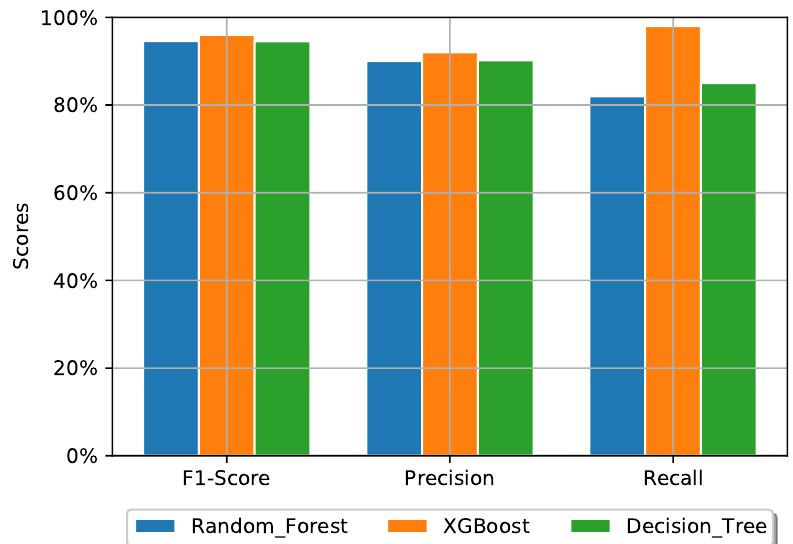
Figure 5. The proposed model XGBoost is compared with other tree-based machine learning algo- rithms, using F1-score, precision and recall as evaluation metrics.